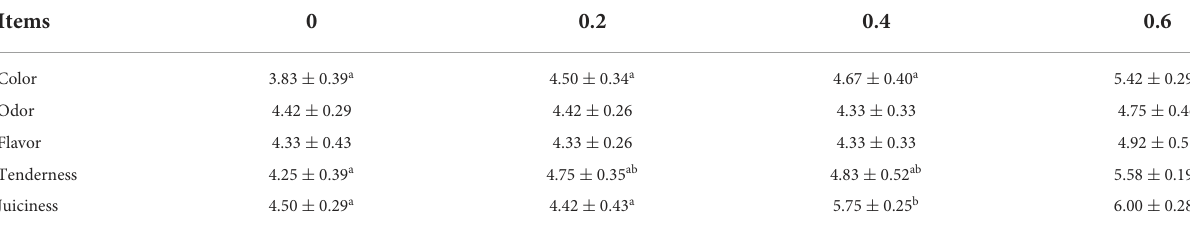
TABLE 5 Effects of dietary quercetin supplementation on the tasting test score in AA broilers.